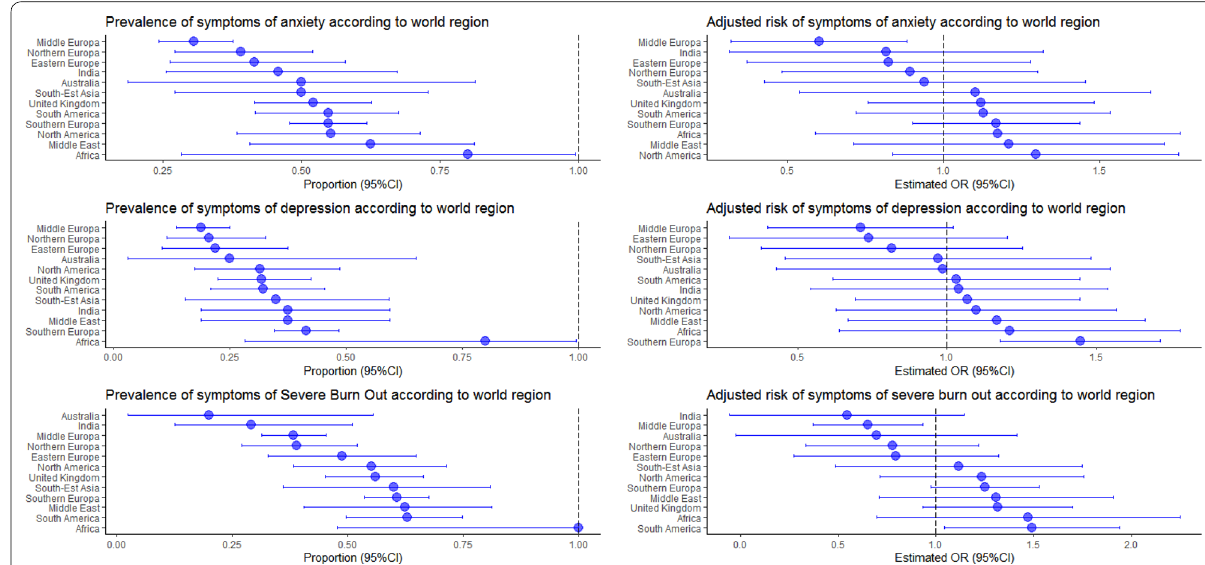
Fig. 4 Prevalence and adjusted prevalence of anxiety, depression and severe burnout in the 12 participating regions